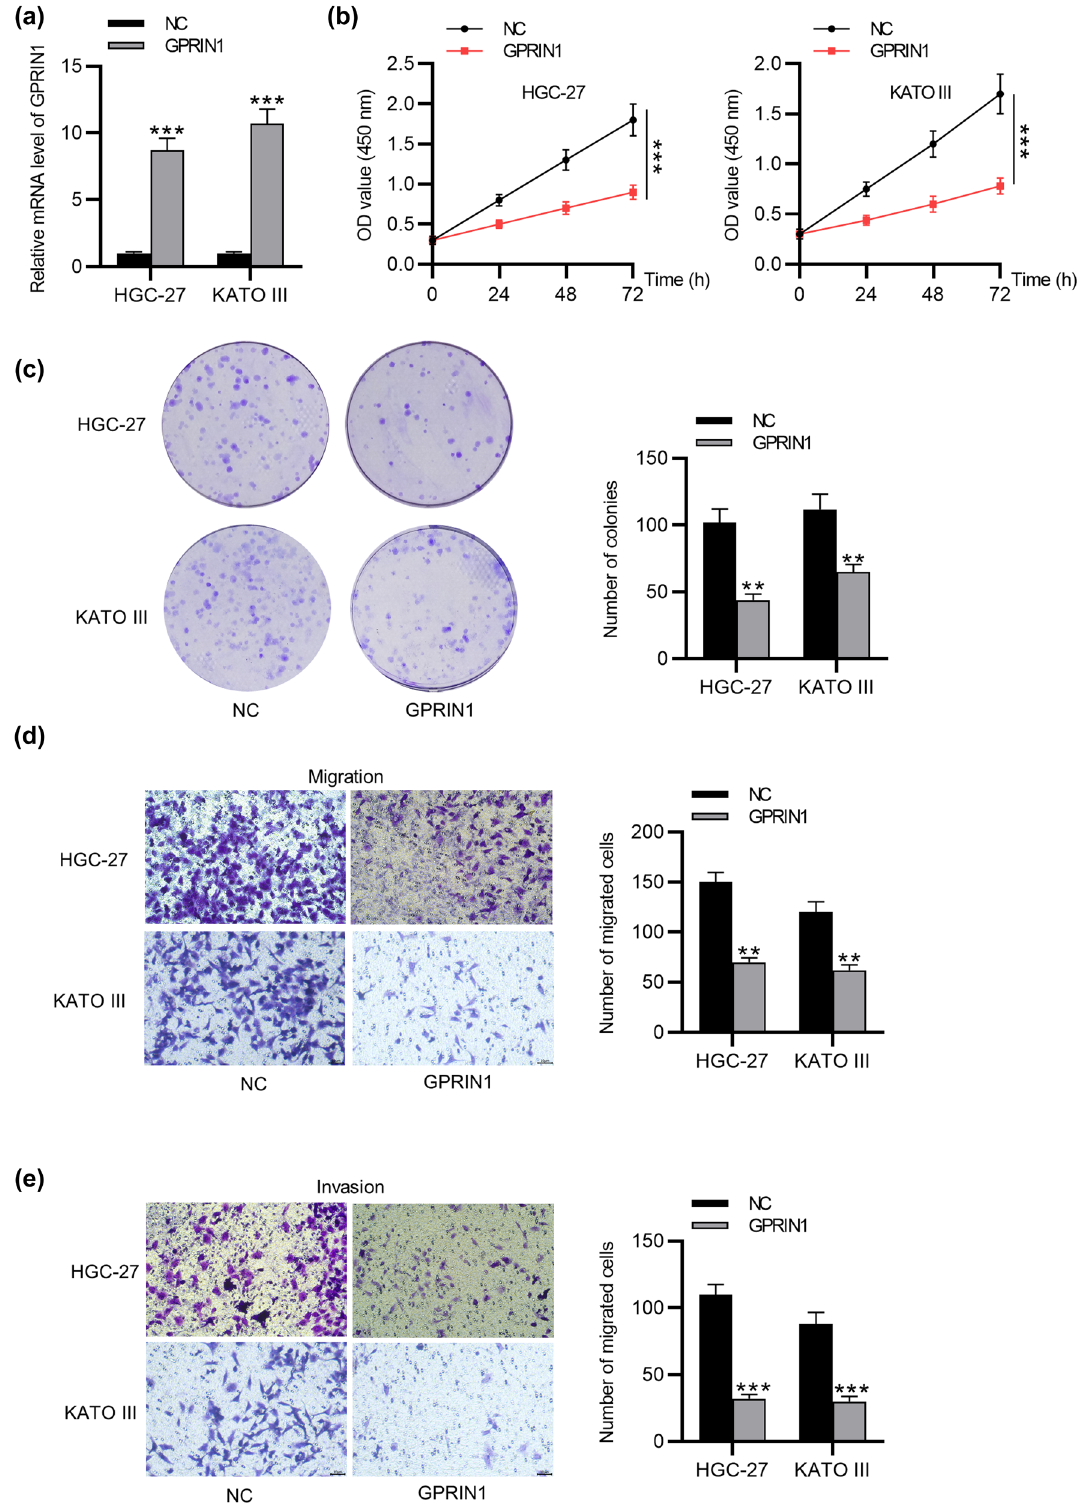
Figure 2: GPRIN1 inhibits proliferation, migration, and invasion of GC cells. ( a ) HGC - 27 and KATO III cells were transfected with pcDNA3.1/ GPRIN1, and the overexpression e ffi ciency was examined by RT - qPCR. ( b ) GC cell viability after GPRIN1 overexpression was detected by a CCK - 8 assay. ( c ) In fl uences of GPRIN1 on GC cell proliferation were explored by a colony formation assay. ( d and e ) Transwell assays were performed to reveal the migration and invasion of GC cells transfected with pcDNA3.1/GPRIN1. ** p < 0.01, *** p <